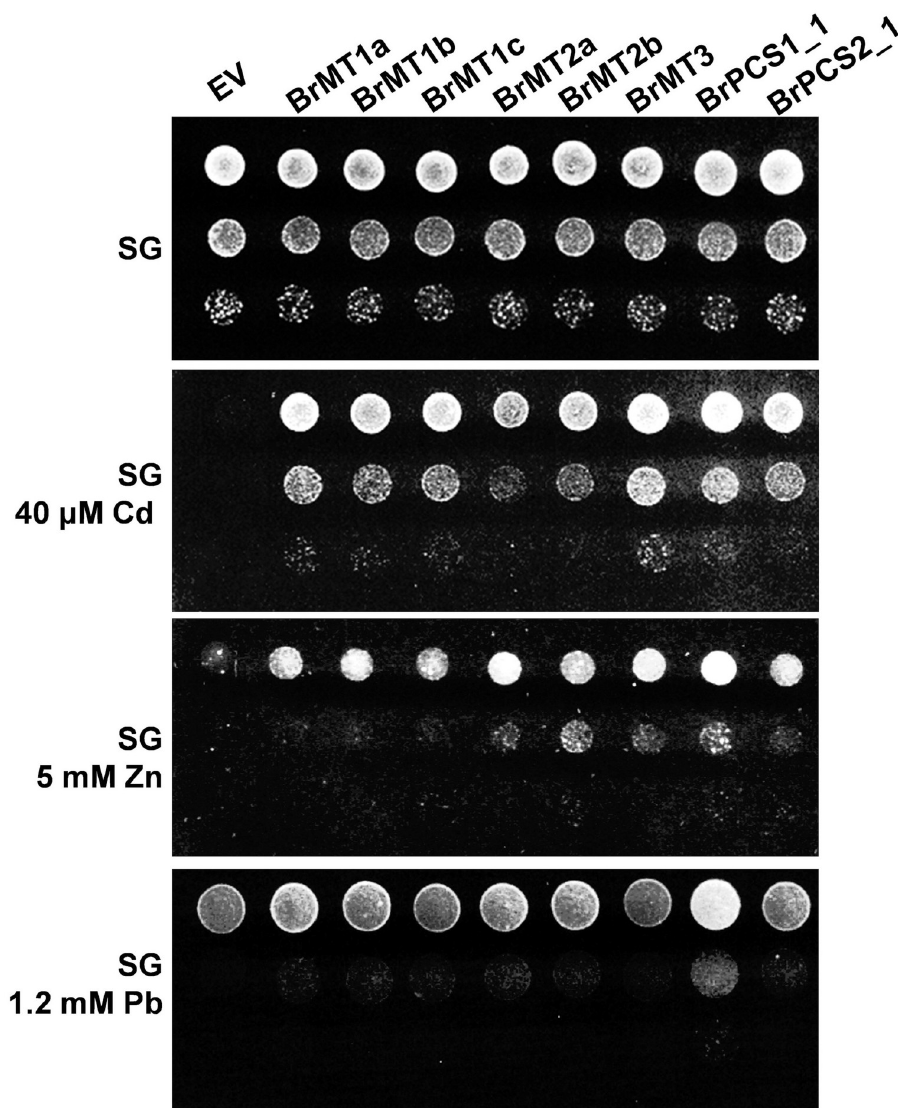
Fig 5. Enhanced heavy metal tolerance in yeast strains expressing B . rapa Cd tolerance genes. DTY167 yeast cells were transformed with empty vector (V), BrMT1a , BrMT1b , BrMT1c , BrMT2a , BrMT2b , BrMT3 , BrPCS1 and BrPCS2 . The yeast strains were cultured in synthetic dextrose without uracil (SD ura − ) liquid medium, spotted on synthetic galactose without uracil (SG ura − ) agar plates supplemented with 40 μ M CdCl 2 , 5 mM ZnSO 4 or 1.2 mM Pb-tartrate, and cultured at 30 ˚C for 3–4